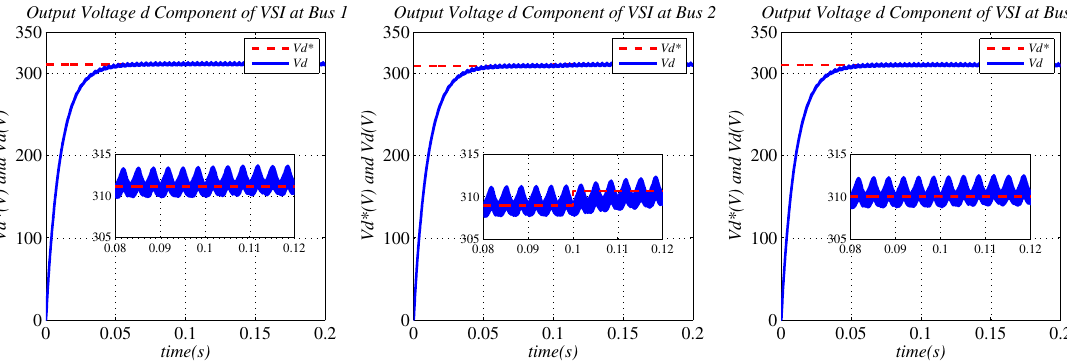
Figure 6. Output voltage d component of the VSI at Buses 1, 2, and 3.